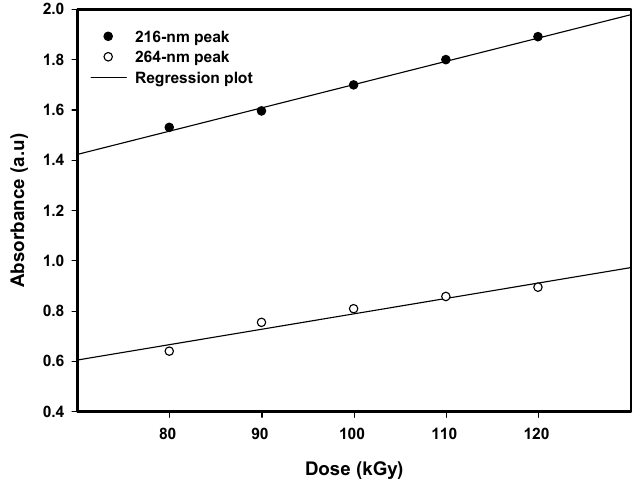
and dose for the 216 and 264 nm absorption peaks. The absorption energy increased from 5.72 to 5.83 eV for the first peak and from 4.69 to 4.75 for the second peak with increasing dose from 80 to 120 kGy due to a reduction in particle size from 5.3 to 3.4 nm (Table 1). Figure 8. Absorption energy of Pt nanoparticles increased with increasing dose from 80 to 120 kGy owing to a reduction in particle size from 5.3 to 3.4 nm which corresponds to the change of the first absorption peak from 216.6 to 212.7nm and the second absorption peak from 264.6 to 260.9 nm (Table 1).